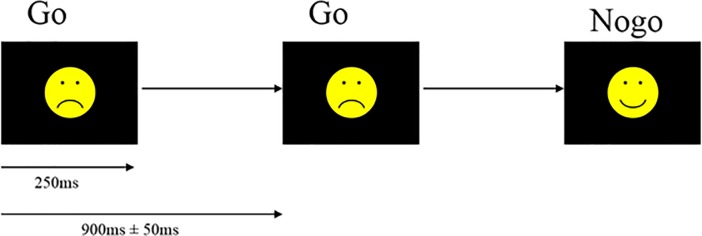
Go/Nogo task design.Go:Nogo ratio was 50:50, with stimulus response pairings switched in the second block so all participants responded to an equal number of happy and sad faces, and stimulus response pairings counter-balanced within each group.